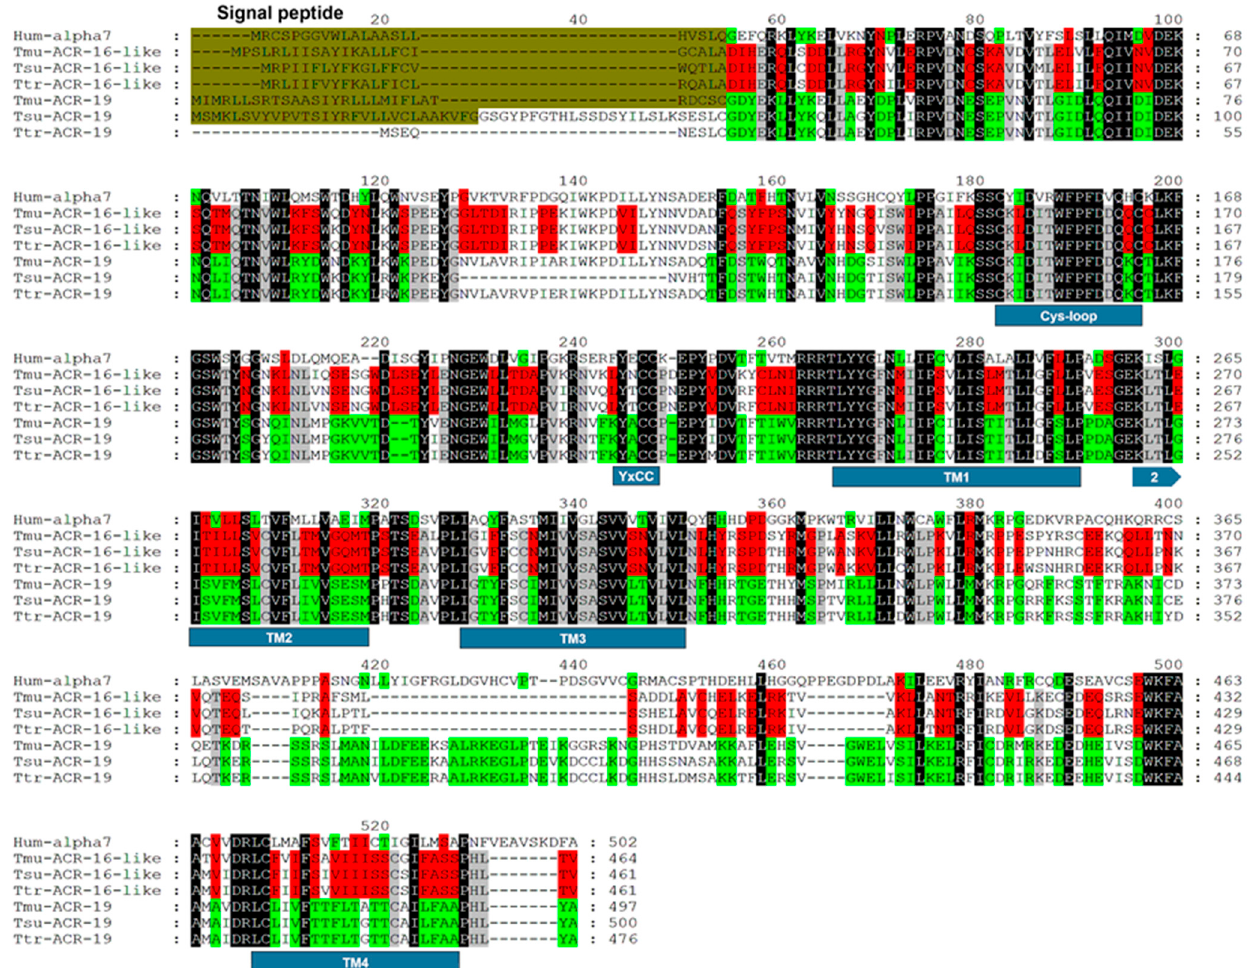
Figure 1. Amino-acid alignment of ACR-16-like and ACR-19 subunits from T. muris, T. suis and T. trichiura and the human α 7 subunit Predicted signal peptide sequences are shaded in dark green, the Cys-loop, the transmembrane regions (TM1-TM4) and the YxCC motif is shown below the sequences. Conserved amino acids between ACR-16-like and ACR-19 subunit sequences are highlighted in black, conserved amino acids for ACR-16-like and ACR-19 are highlighted with red and green, respectively, nematode specific amino acids are highlighted in grey.